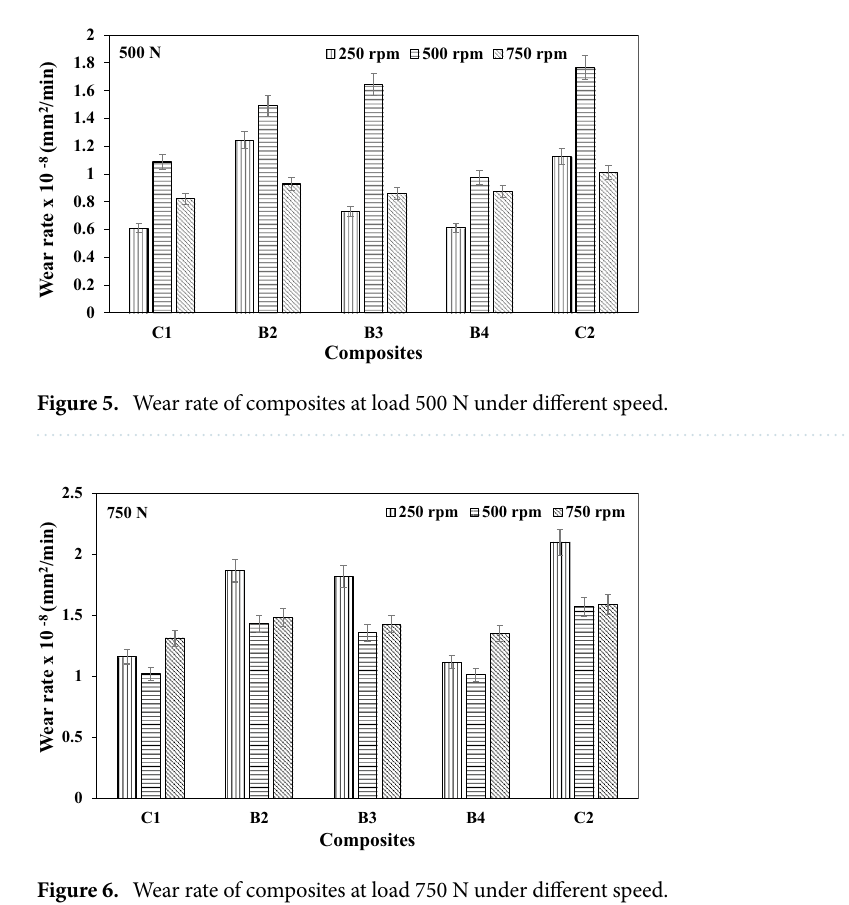
Figure 6. Wear rate of composites at load 750 N under different speed.